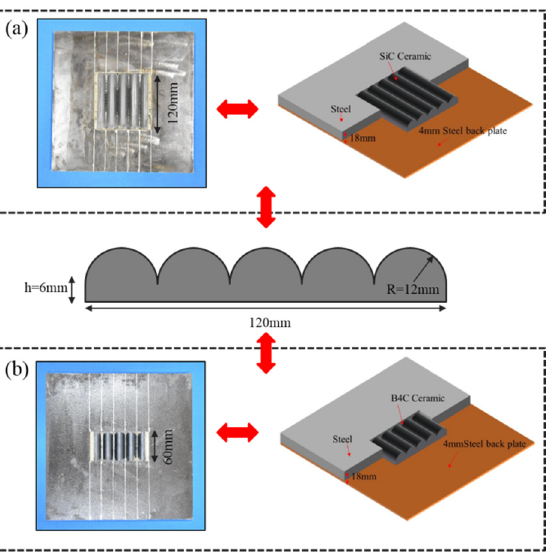
Figure 1. Schematic diagram of composite armor, ( a ) SiC Ceramic composite armor, ( b ) B 4 C Ceramic composite armor.